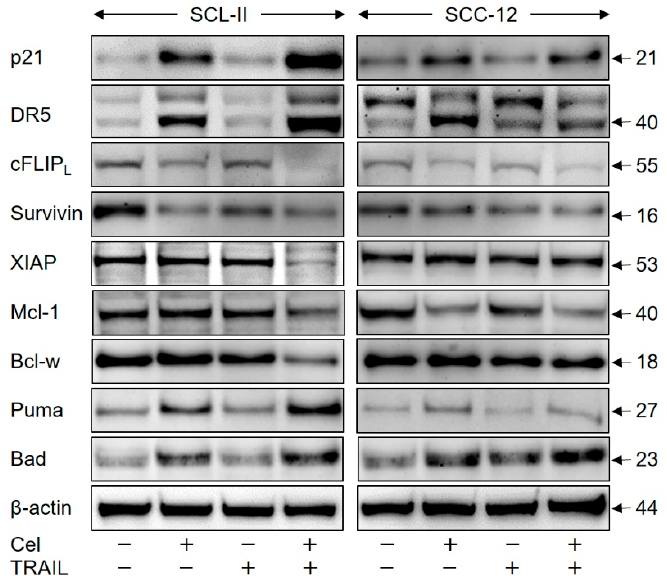
Figure 7. Regulation of characteristic mediators of apoptosis and cell proliferation. Cell lines SCL-II and SCC-12 were treated for 24 h with celecoxib (50 µM), TRAIL (50 ng/mL) or the combination. Expression levels of p21 (21 kDa), TRAIL-R2/DR5 (40 kDa), cFLIP (long isoform, 55 kDa), survivin (16 kDa), XIAP (53 kDa), Mcl-1 (40 kDa), Bcl-w (18 kDa), Puma (27 kDa) and Bad (23 kDa) were analysed by Western blotting. Analysis of β -actin (44 kDa) served as loading control. Largely similar results were obtained in three independent Western blot experiments using three independent series of cell extracts.